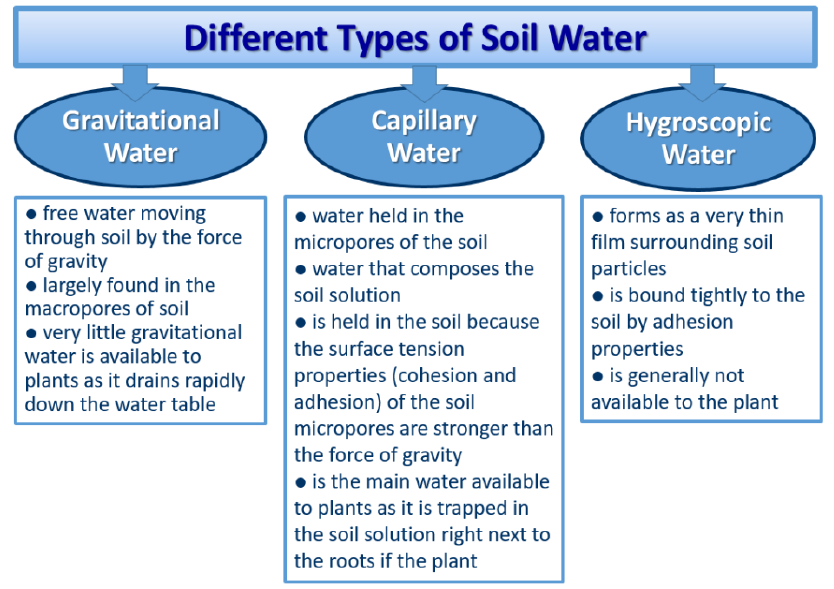
Figure 2. The three main types of soil water-gravitational water, capillary water, and hygroscopic water.